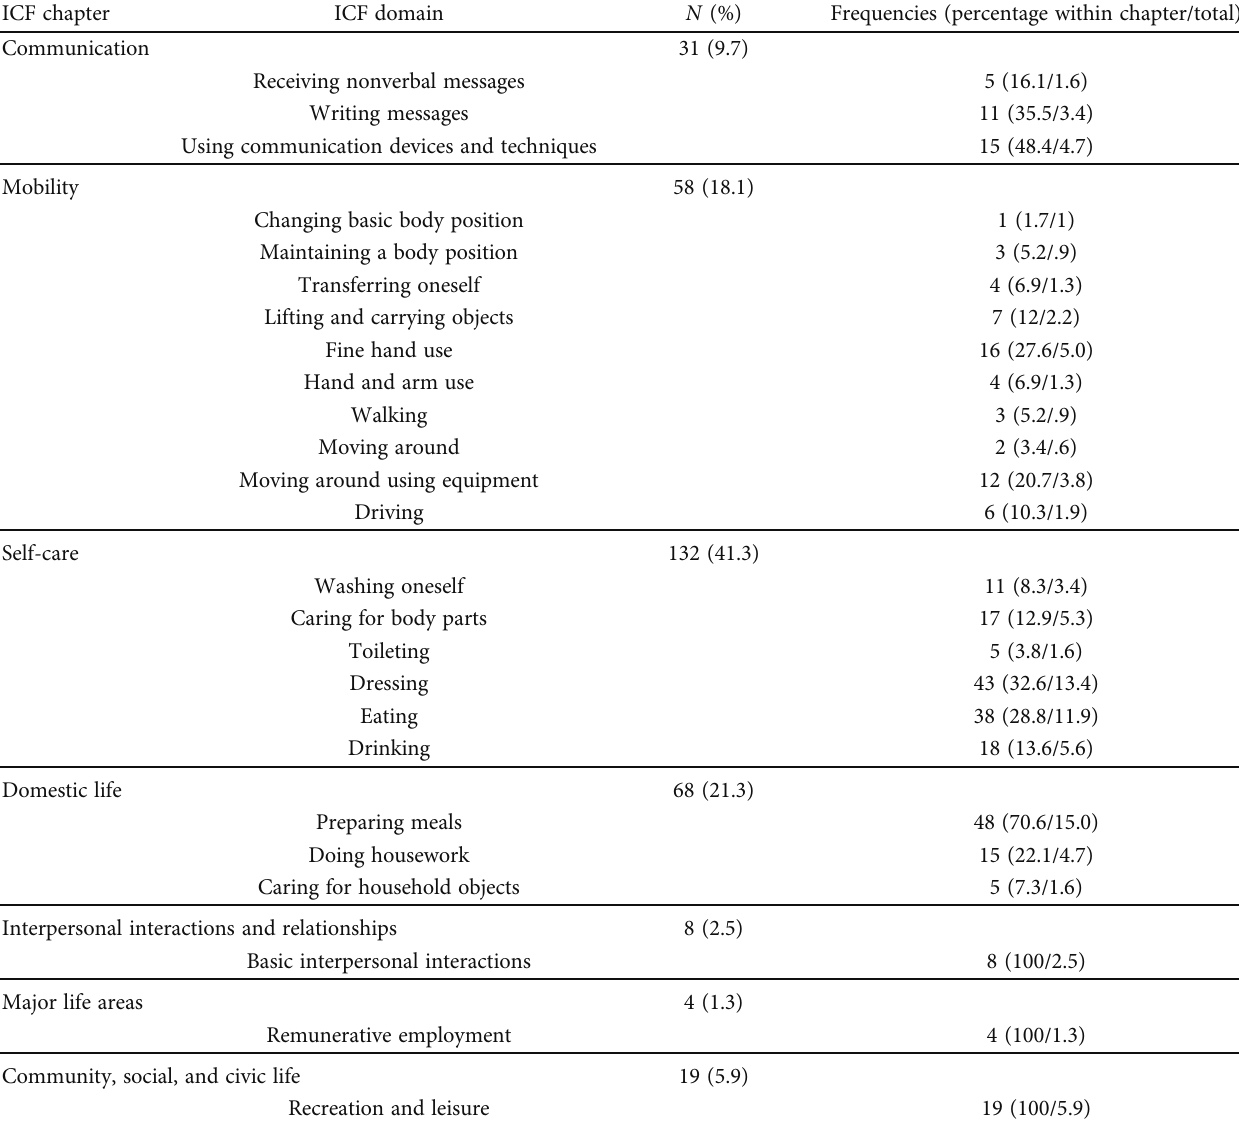
Table 2: Mapping occupational performance goals according to the International Classi fi cation of Function, Disability, and Health (ICF) ( n = 320